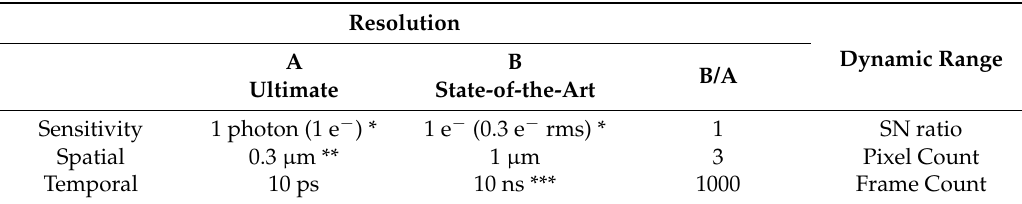
Table 1. Fundamental performance of silicon image sensors (expressed by round